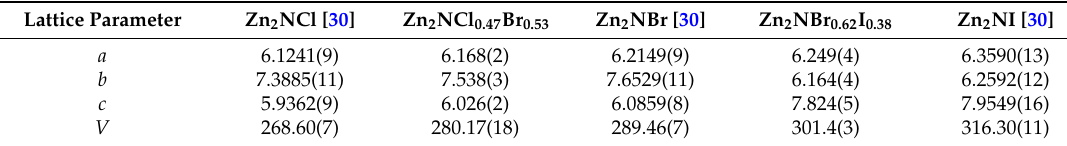
Table 2. Lattice parameter for Zn 2 NX 1 − y X (cid:48) y (X, X (cid:48) = Cl, Br, I; 0 < y < 1). Lattice Parameter